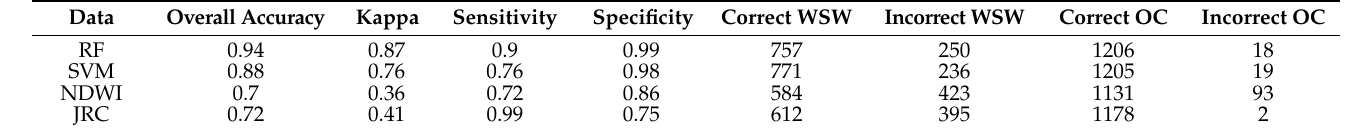
Table 5. Accuracy assessment of supervised classification of wetland surface water (WSW) vs. other classes (OC) for 2017 on the test data subset that was withheld from model